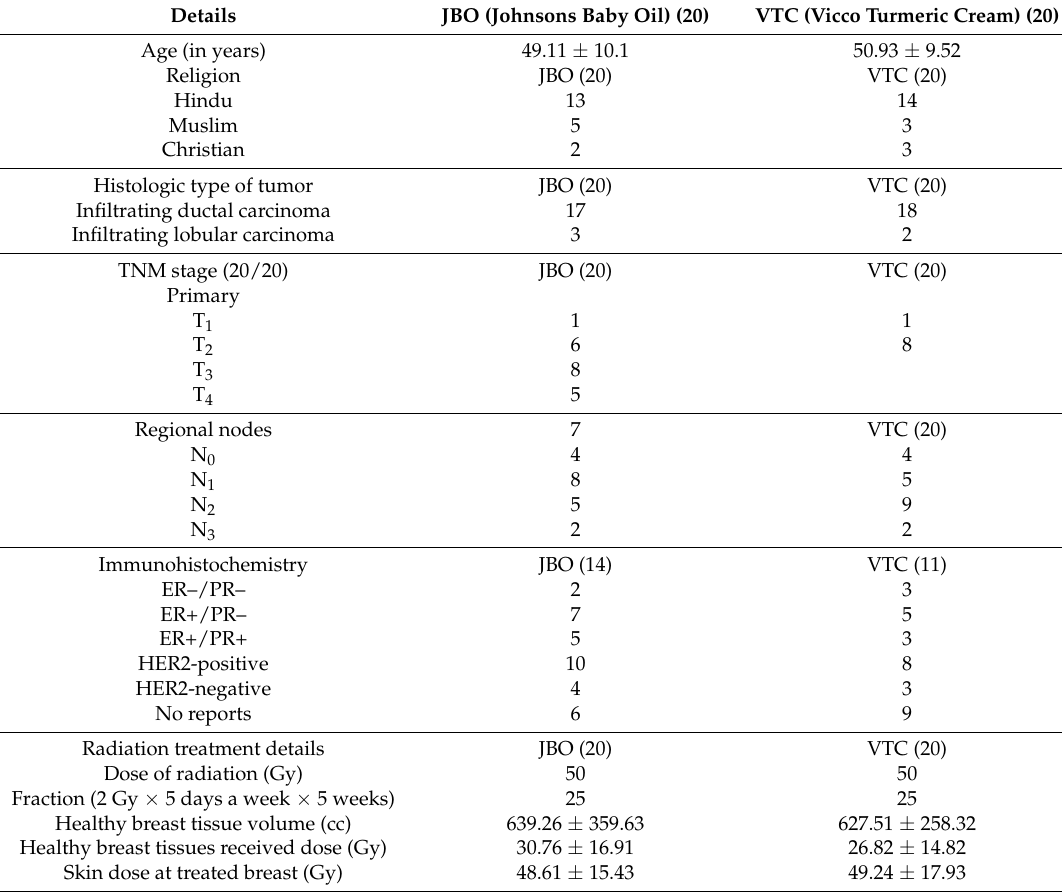
Table 1. Patient and tumor